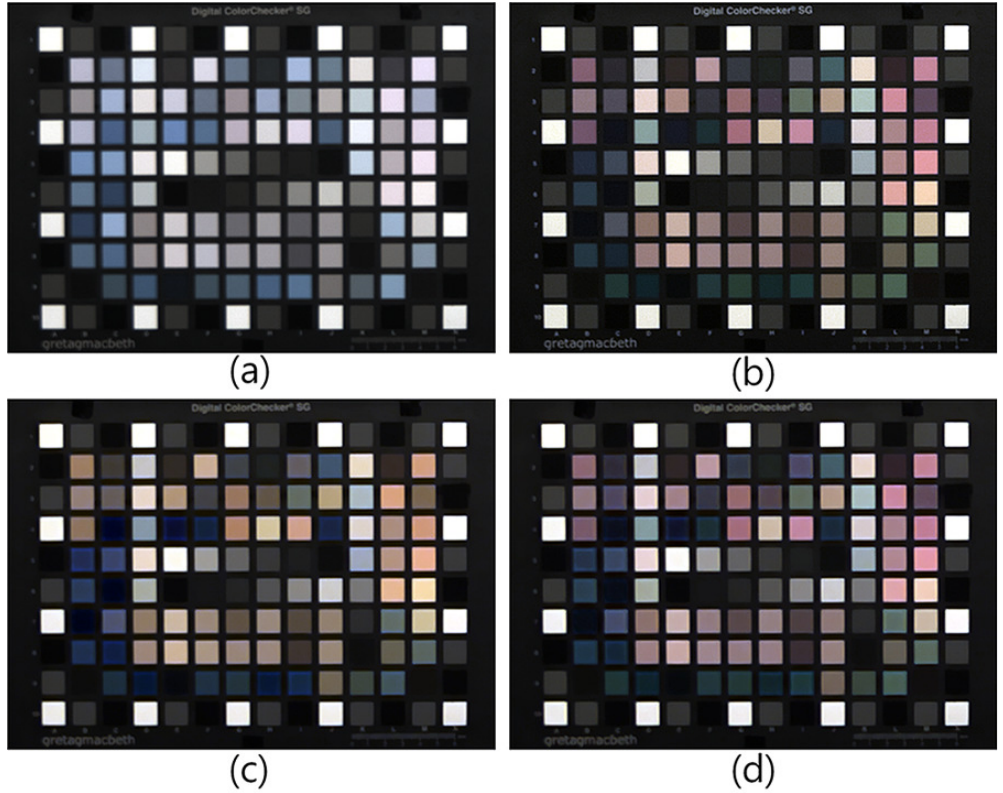
Figure 15. Comparison between proposed methods (incandescent, 5 lx). ( a ) Multi-spectral image; ( b ) optical filtered image; ( c ) proposed method without two-step color restoration; ( d ) proposed method with two-step color